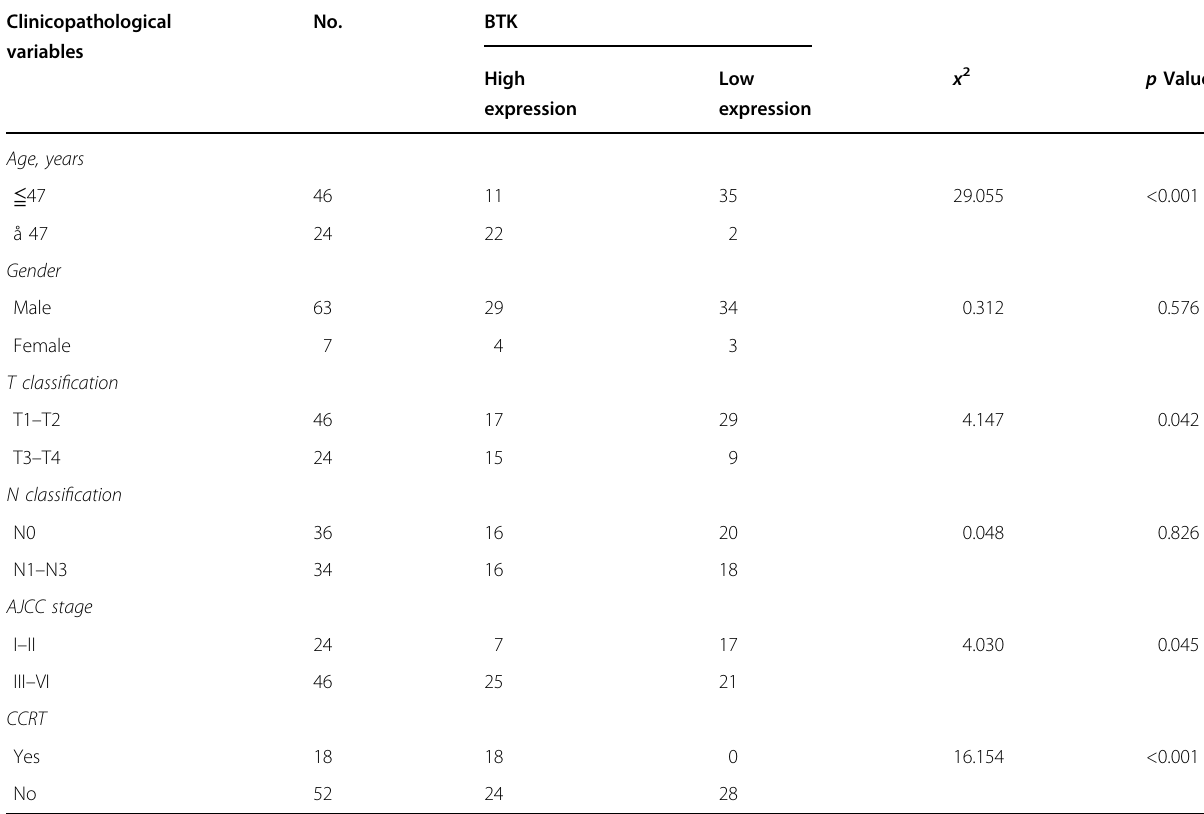
Table 1 Correlation between BTK expression and clinicopathological variables of TSGH-OSCC patients ( n = 70). Clinicopathological variables